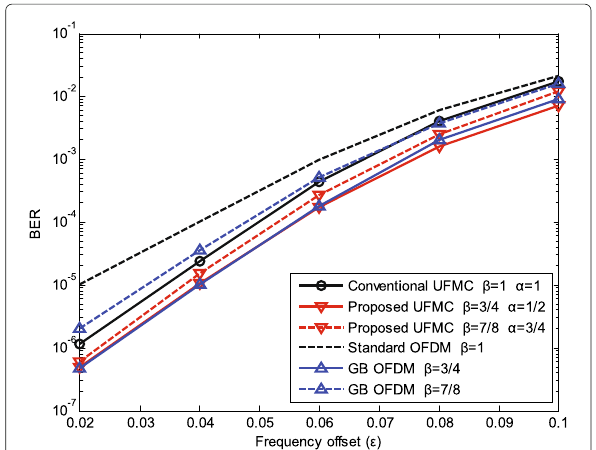
BER increases from 10 − 3 to 10 − 2 when Eb/N0 is 20